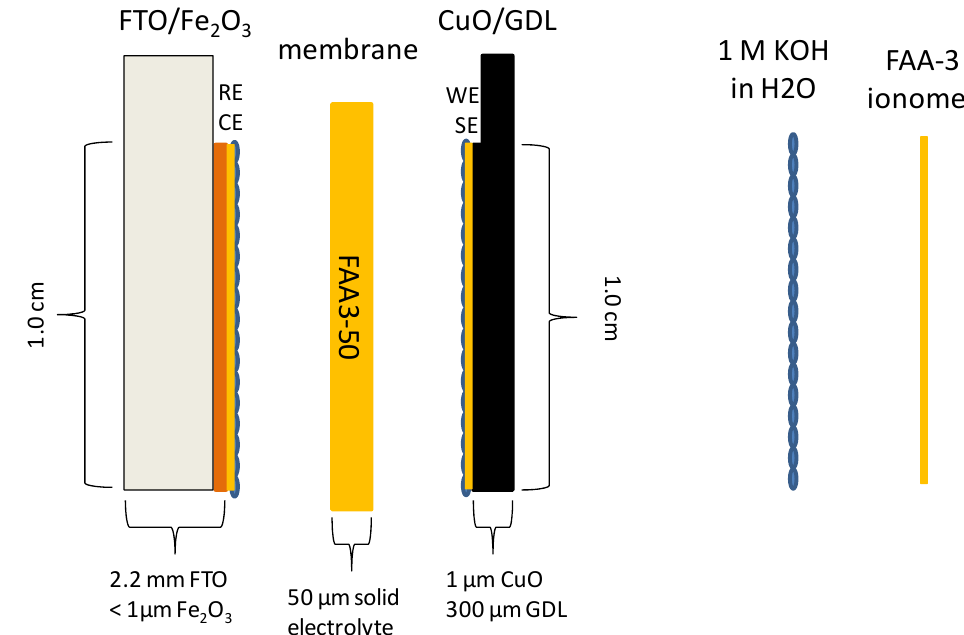
Figure 1. Sketch of the photo-electro-chemical cell for water-splitting.